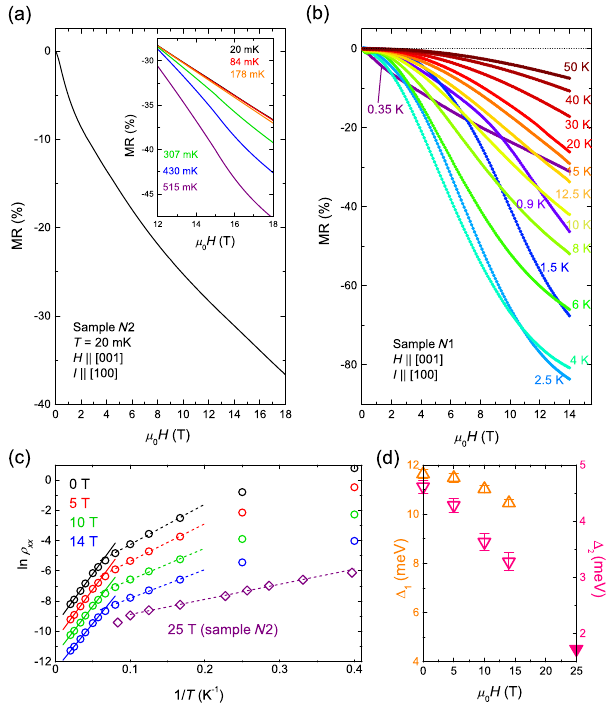
0 Þ(cid:2) = ρ 0 Þ × 100% H Þ - ρ FIG. 10. (a) Transverse MR [ ρ xx ð xx ð xx ð measured in sample N 2 at T ¼ 20 mK, with magnetic field up to 18 T applied along [001] and current I k [100]. Inset exhibits transverse MR of sample N 2 between 12 and 18 T at various temperatures. (b) Transverse MR of sample N 1 up to 14 T for temperatures between 0.35 and 50 K. (c) The Arrhenius plot ln ρ versus 1 =T for sample N 1 under different magnetic fields xx up to 14 T (hollow circles). The slopes of the linear fits for temperature ranges 17 . 5 K ≤ T ≤ 50 K (solid lines) and 6 K ≤ T ≤ 12 . 5 K (dashed lines) give the value of gap widths Δ 1 (up triangles) and Δ 2 (down triangles) in (d), respectively. Data taken in sample N 2 at 25 Tare also displayed with the linear fit between 3 and 8 K yielding Δ 2 ¼ 1 . 725 meV [solid down triangle in (d)]. The plots are shifted vertically by 1 for